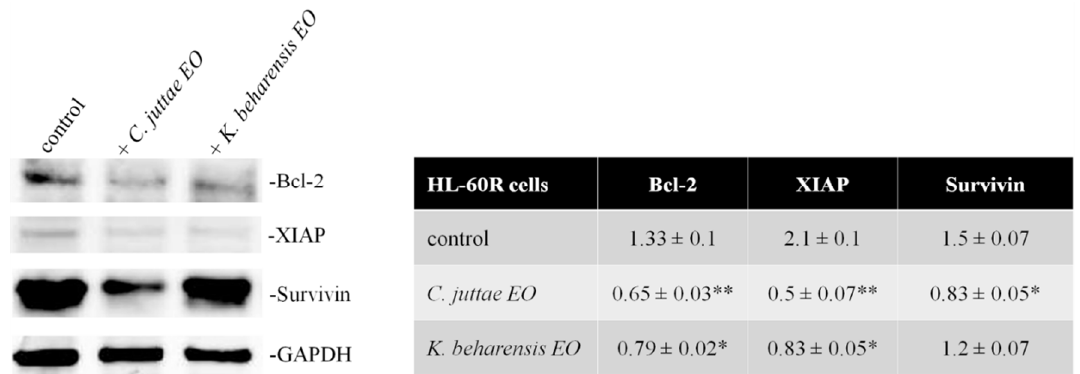
Figure 9. Western blotting analysis of the levels of Bcl-2, XIAP and Survivin, in HL-60 R cells treated for 24 h with C. juttae or K. beharensis essential oils (40 μg/mL). On the left the results of a representative experiment; on the right, the results expressed as mean ± standard error of two different experiments. Differences when treatments are compared to the control: * p < 0.05; ** p < 0.01.